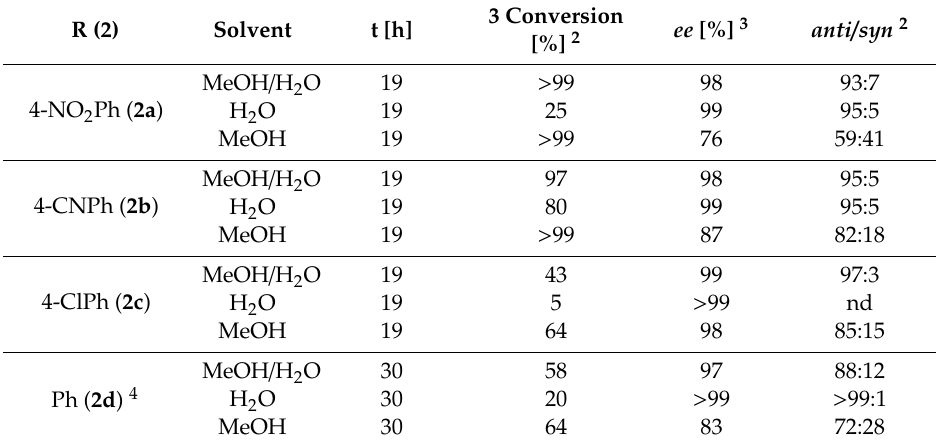
Scheme 1. The benchmark aldol reaction. Table 1. Comparison of di ff erent protic reaction media 1 Table 1. Comparison of different protic reaction media 1 .